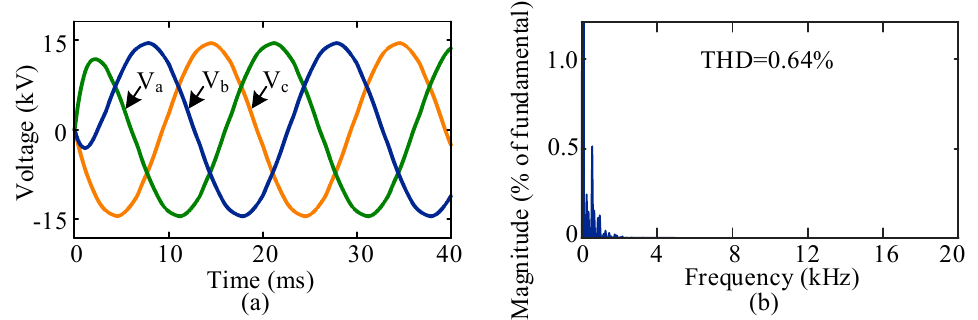
Figure 9. With the proposed TSCMPWM: ( a ) filtered line voltages and ( b ) frequency spectra. Figure 10 depicts the comparative THDs of inverter line voltage for the existing and the proposed TSCMPWM techniques.